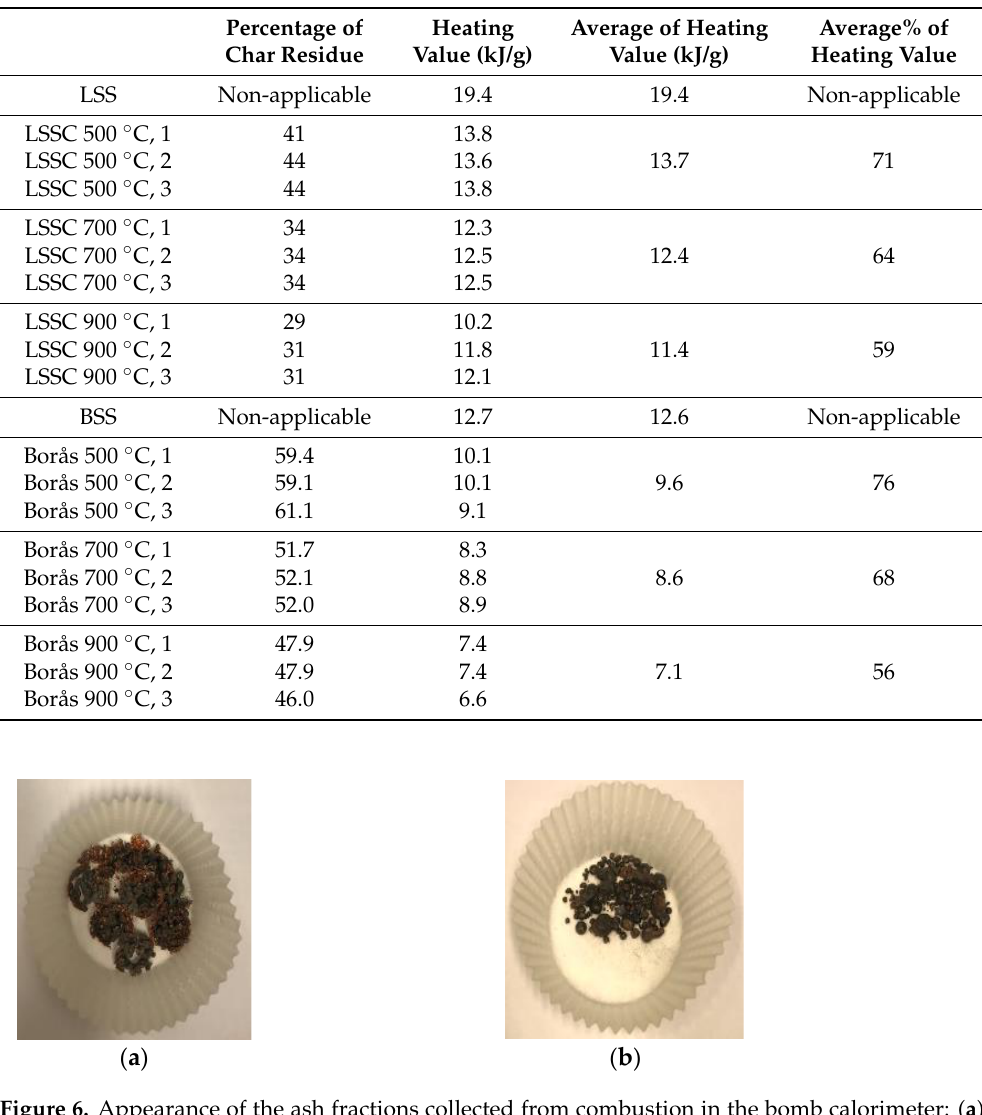
Table 3. Characterizations of char residues obtained from the pyrolysis of Lidköping and Borås sewage sludge.